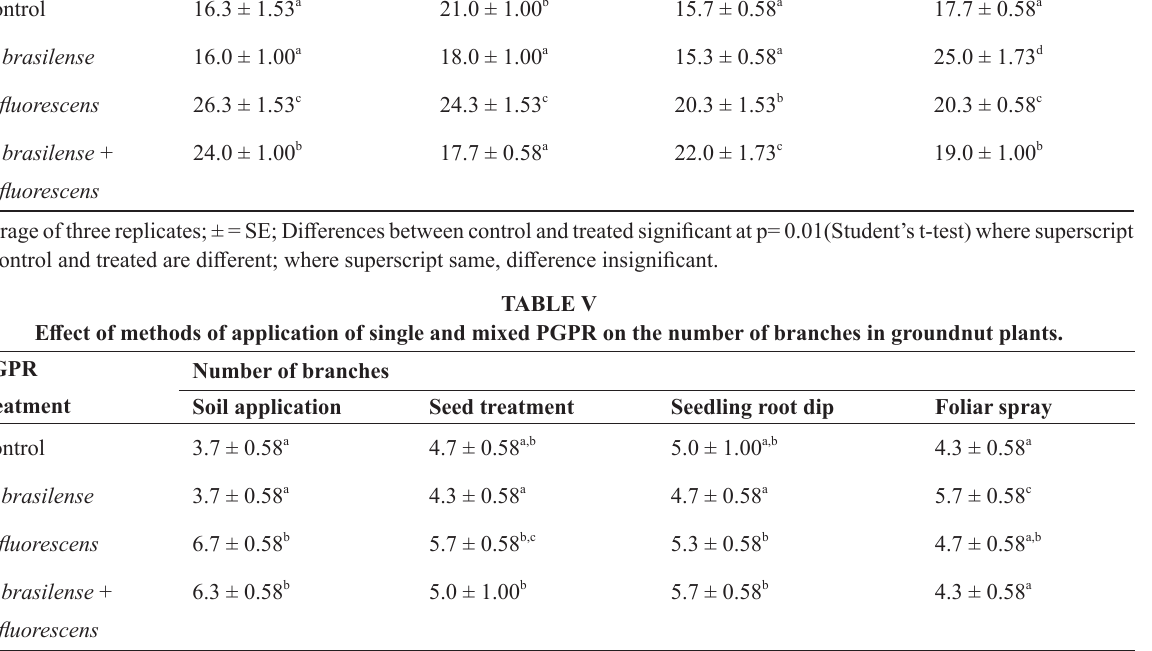
Average of three replicates; ± = SE; Differences between control and treated significant at p= 0.01(Student’s t-test) where superscript of control and treated are different; where superscript same, difference